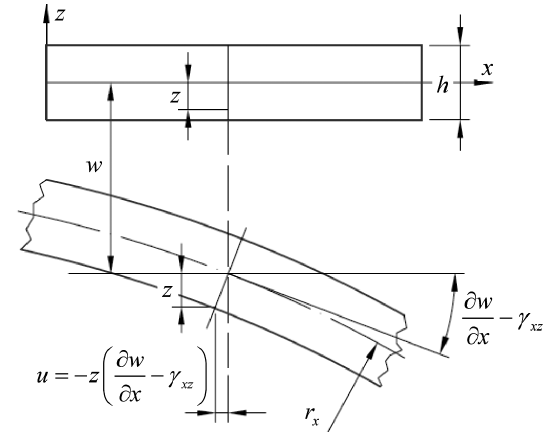
Fig. 1. Transverse shear deformations [24].